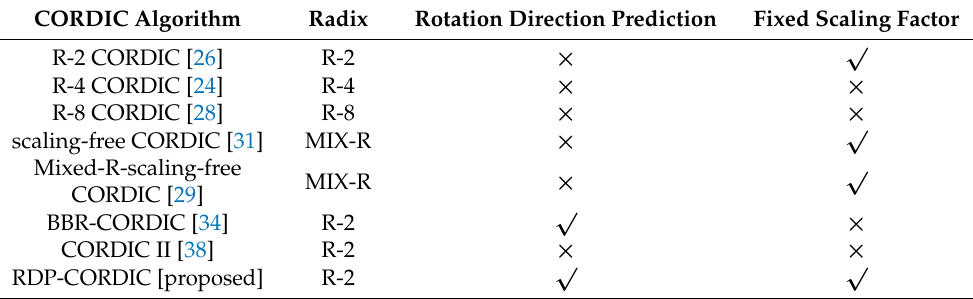
Table 2. Features of related CORDIC algorithms.